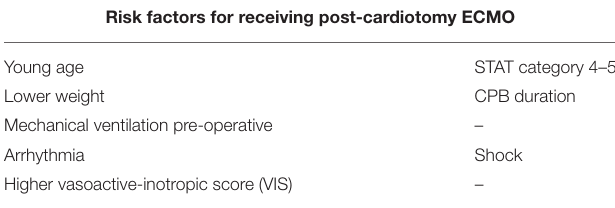
TABLE 2 | Risk factors for receiving ECMO following neonatal heart surgery. Risk factors for receiving post-cardiotomy